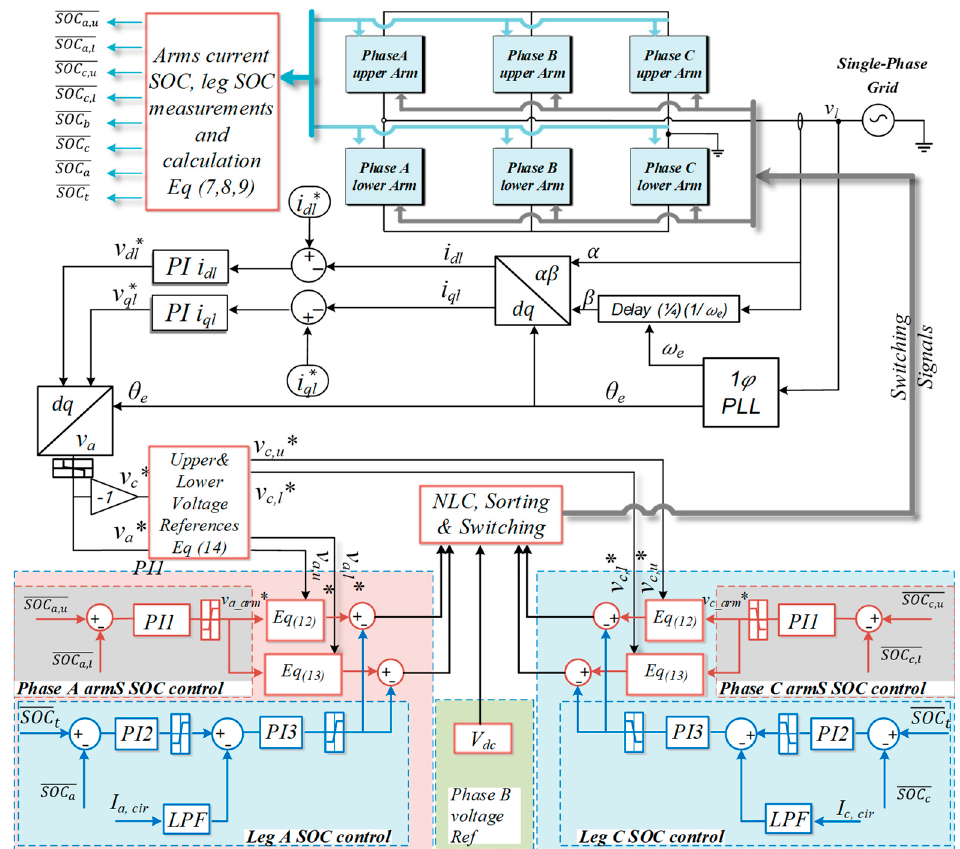
Figure 2. Developed MMC-EB single-phase charging system arrangement.